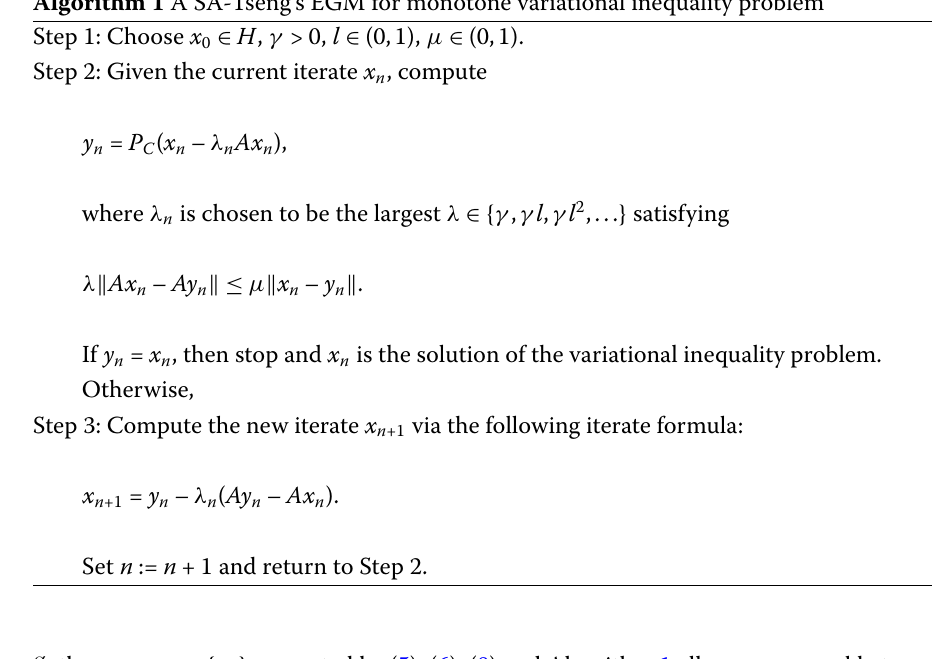
Algorithm 1 A SA-Tseng’s EGM for monotone variational inequality